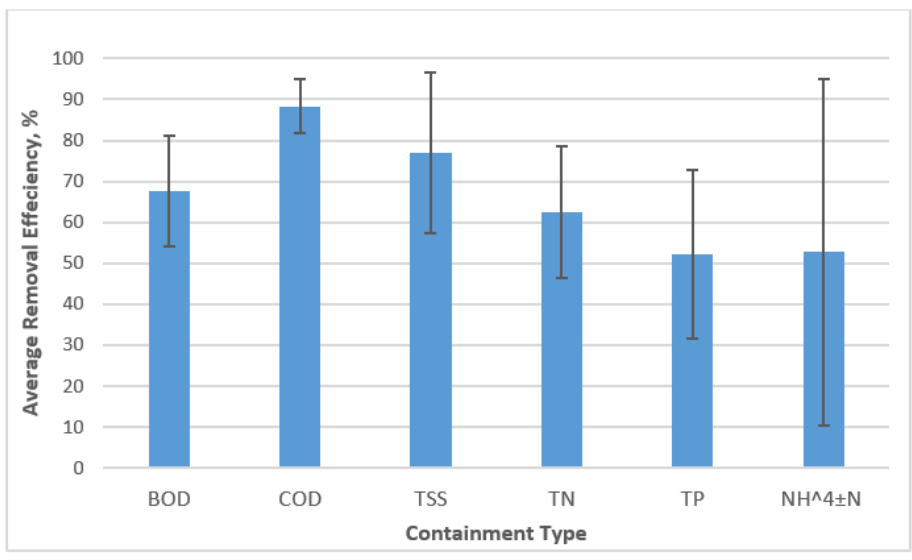
Figure 3. Horizontal flow lab scale systems removal efficiency.